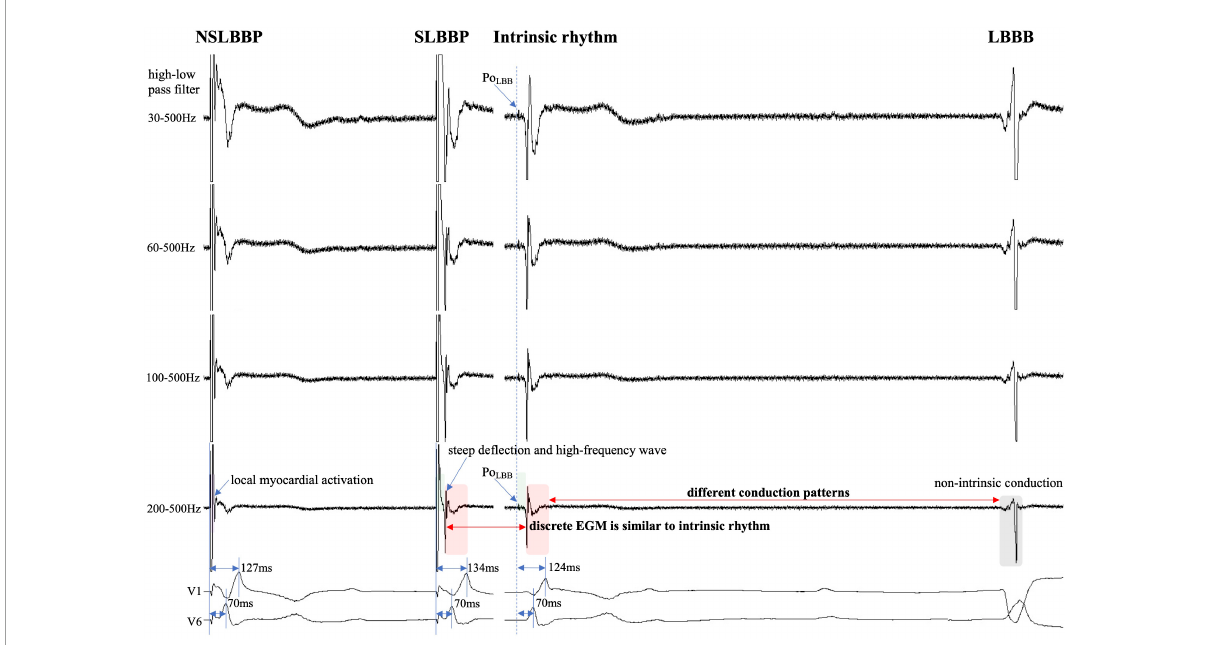
FIGURE3 Discrete local ventricular EGM morphology resembles ventricular EGM morphology of intrinsic rhythm (red rectangle). The EGM morphology of LBBP is similar to the native rhythm but is completely different from the EGM morphology of LBBB (red and gray rectangle). Po LBB can be observed at different high-pass filter settings (blue dashed line). Isoelectric interval does not appear during local myocardial activation (purple rectangle). Isoelectric interval is affected by pacing artifacts (green rectangle). Abbreviations as in Figure 1 .